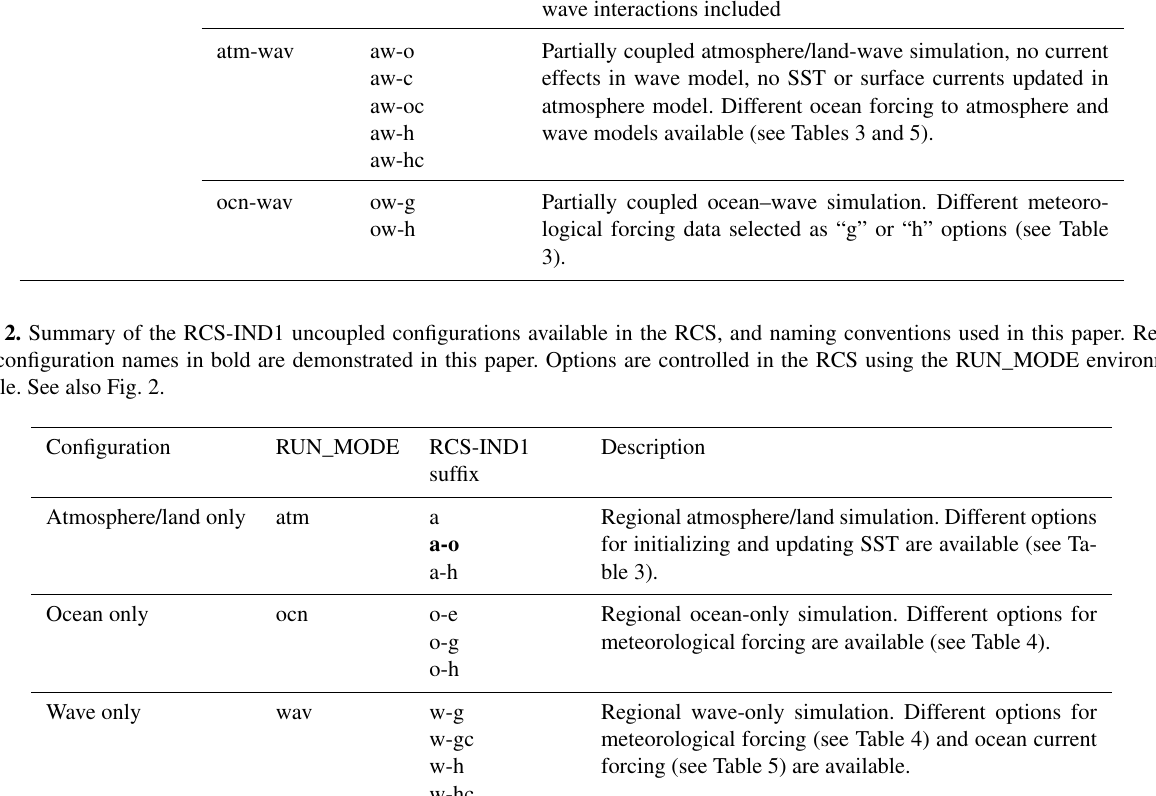
Regional atmosphere/land simulation. Different options for initializing and updating SST are available (see Ta- ble 3). Regional ocean-only simulation. Different options for meteorological forcing are available (see Table 4). Regional wave-only simulation. Different options for meteorological forcing (see Table 4) and ocean current forcing (see Table 5) are